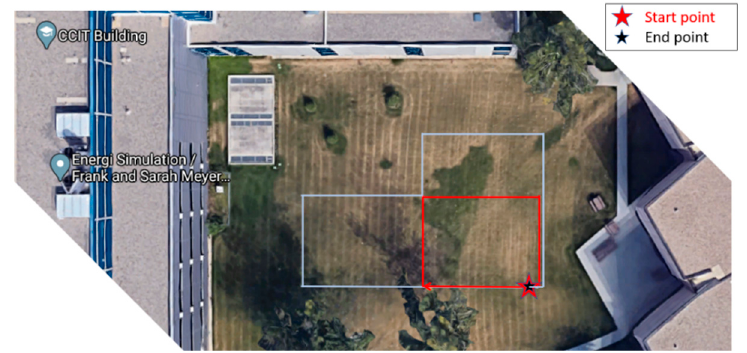
Figure 20. Outdoor trajectory.